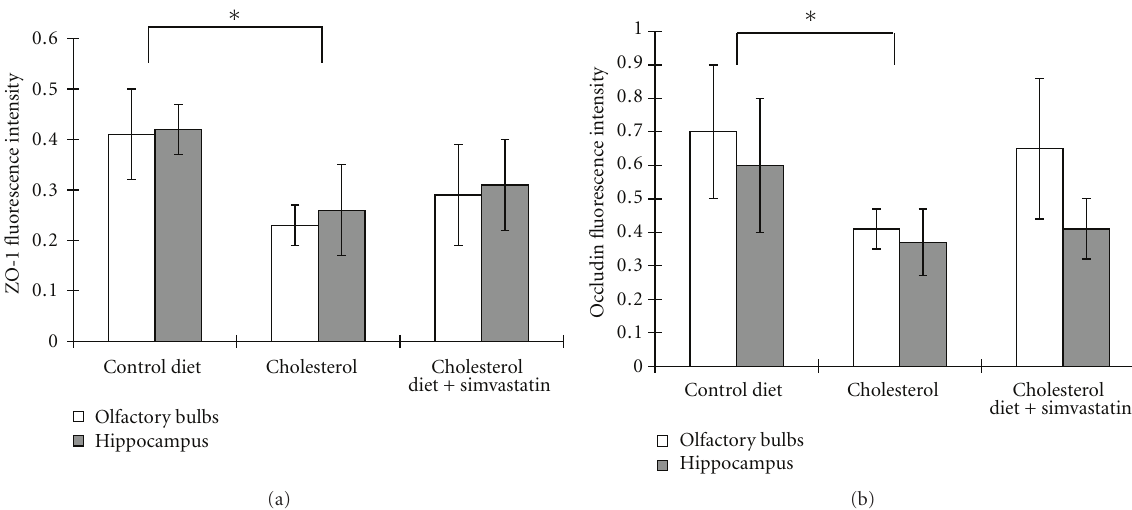
Figure 3: Simvastatin has no e ff ect on high-cholesterol diet-induced downregulation of tight junction proteins. Images from Figure 2 were analyzed with Image J software. (a) Quantitative data from Figure 2(a) demonstrates that a high-cholesterol diet significantly decreases ZO-1 immunoreactivity in the olfactory bulbs and hippocampus, an e ff ect that was not blocked by simvastatin. (b) Quantitative data from Figure 2(b) demonstrates that a high-cholesterol diet significantly decreased occludin immunoreactivity in the olfactory bulbs and hippocampus. However, this e ff ect was not blocked by simvastatin treatment (5mg/kg/day for 4 weeks) ( n = 8, ∗ P < 0 . 05).